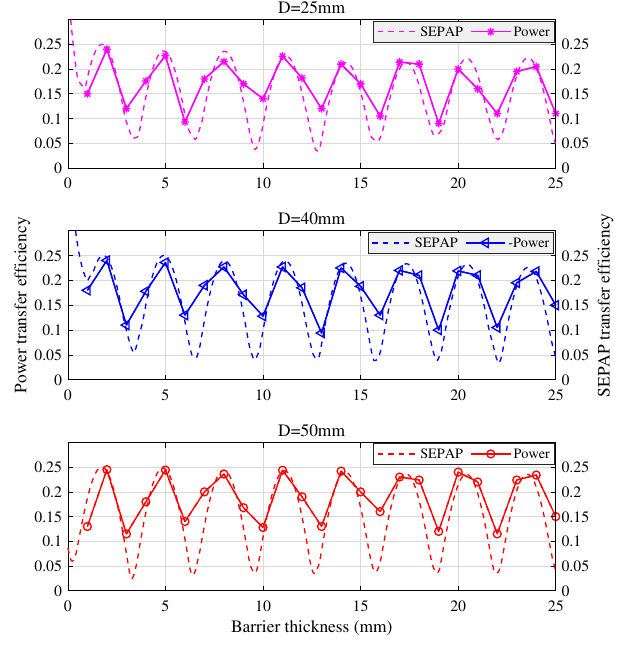
Figure 11. Impact of transducer size on SEPAP and power transfer